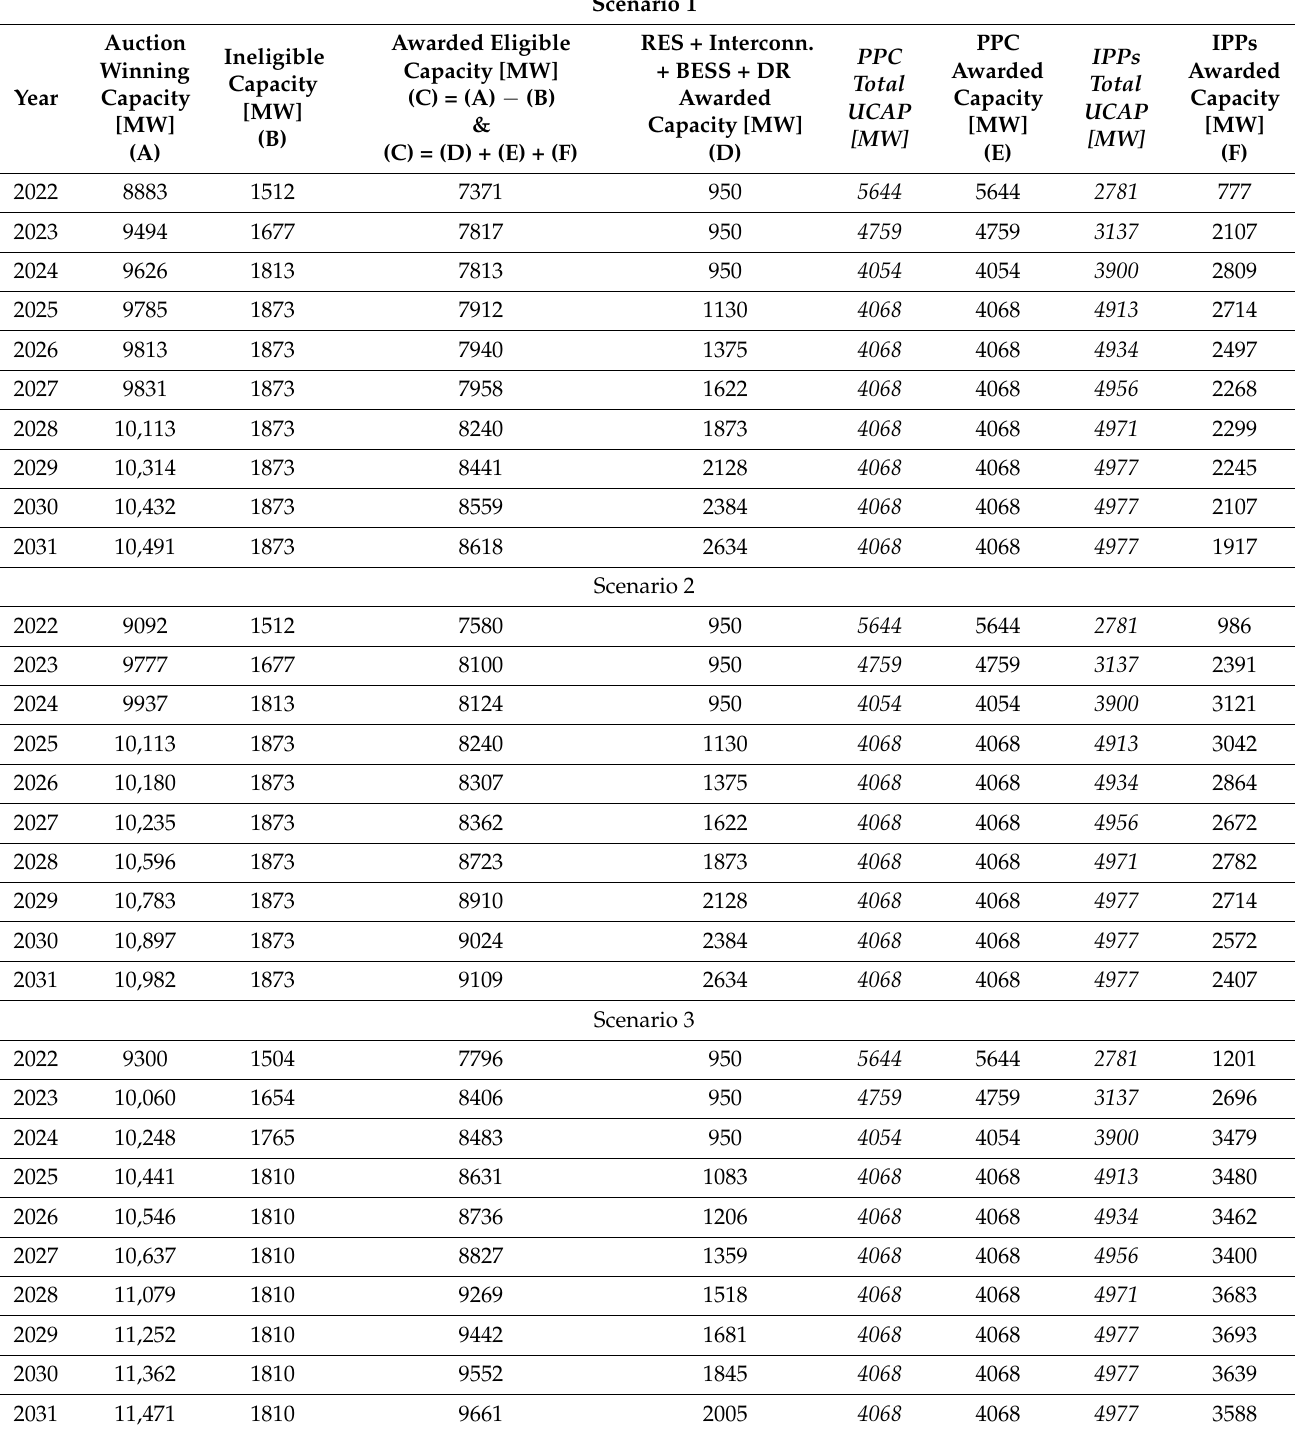
Table 3. CRM auction clearing results–Base